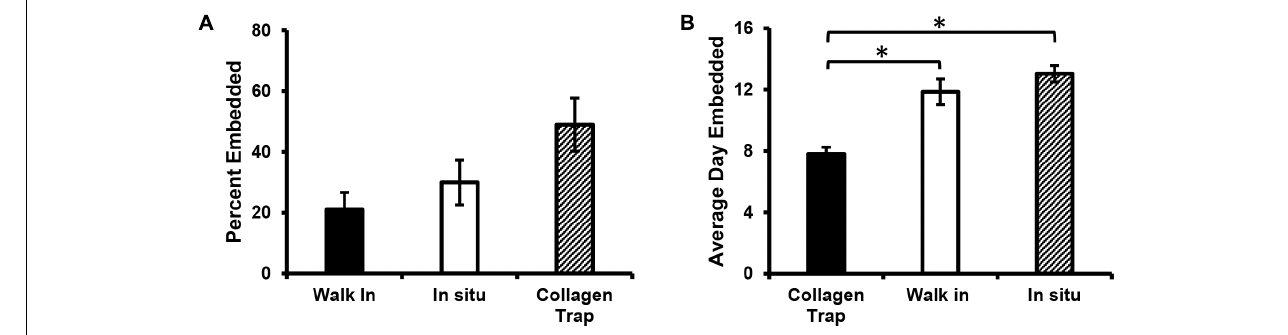
FIGURE 7 | Mechanism of osteocyte embedding may be dependent on the maturation of the bone nodule. (A) Quantitation of the percentage of Dmp1-Cre/tdTomato-positive cells that embed via the three different mechanisms identified, including collagen entrapment, switching on tdTomato in situ and “walking” into an already formed collagen lacuna. (B) Graph showing the average day on which embedding occurred for cells in the three embedding categories. Data in (A,B) are mean ± SEM from n = 4 independent movies (86 individual embedding cells analyzed). (B) ∗ p < 0.05,